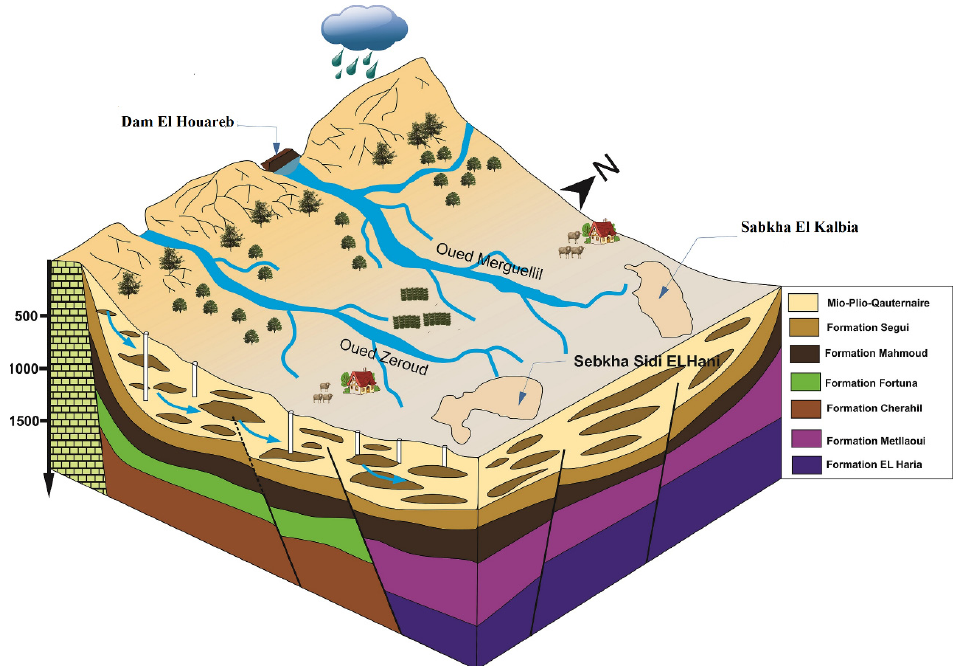
Figure 6. 3D geological conceptual model of the study area.